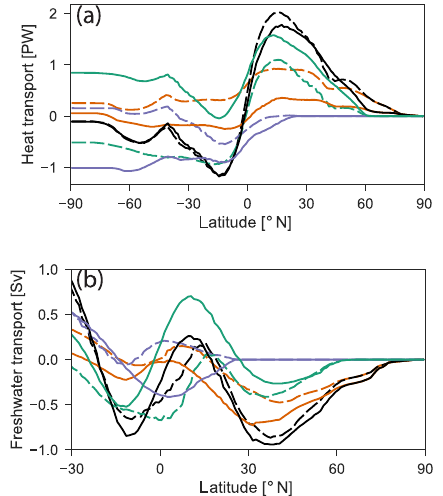
Figure 15. Northward implied ocean transport of (a) heat and (b) freshwater. Black: global, orange: Atlantic, turquoise: Pacific, and violet: Indian Ocean. Solid: RETRO, dashed: